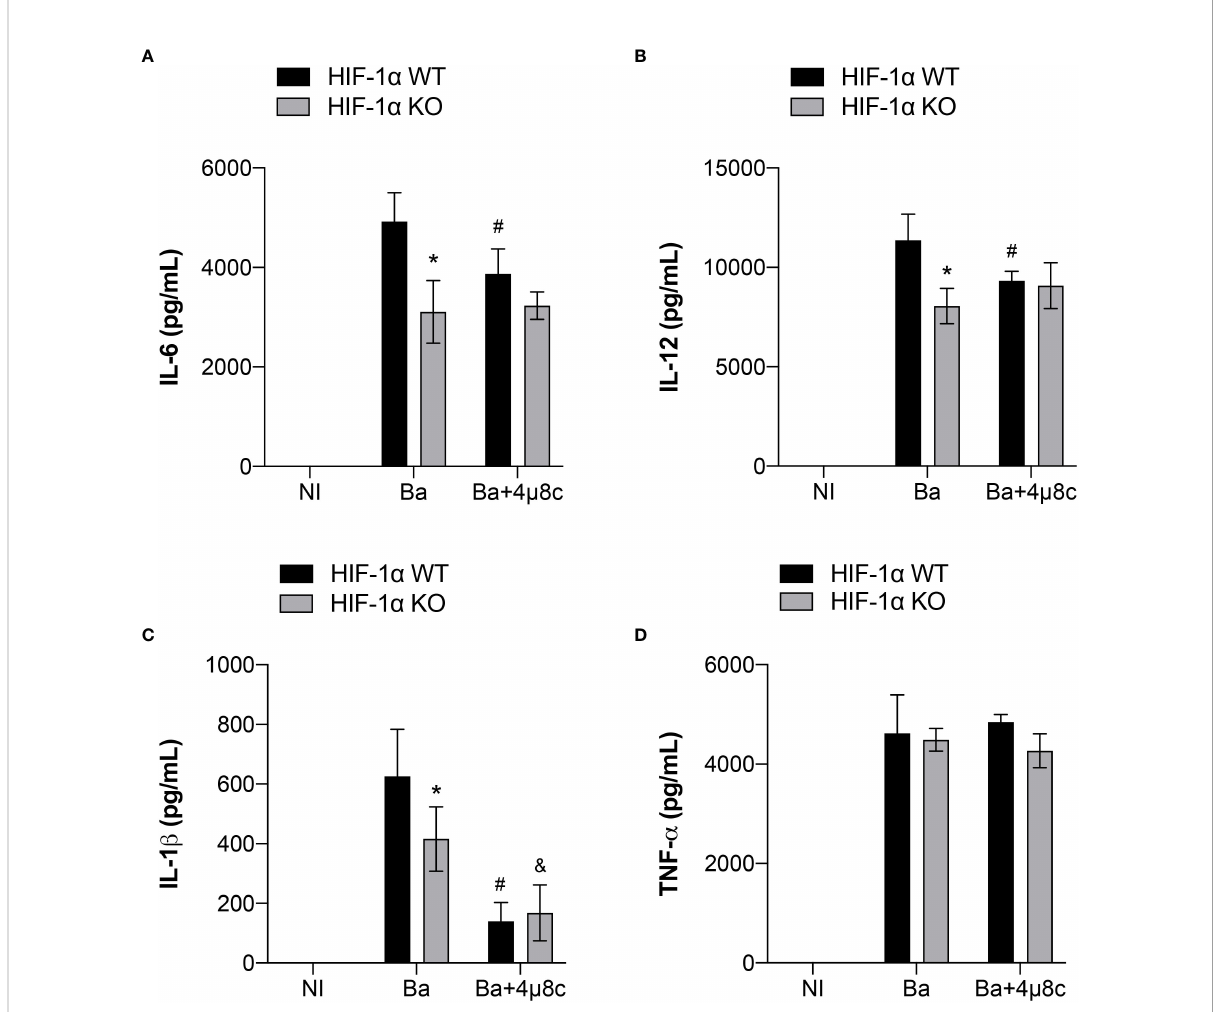
FIGURE 6 IRE1 a is necessary for full induction of HIF-1 a -dependent in fl ammatory responses during infection. (A) IL-6, (B) IL-12, (C) IL-1 b and (D) TNF- a produced by macrophages derived from HIF-1 a WT and HIF-1 a KO mice non-infected (NI), infected with B abortus (Ba) or pre-treated with 4 m 8c (50 m M) and infected with B abortus (Ba+4 m 8c), detected in cell supernatants using ELISA. The data are representative of three independent experiments. The data are presented as mean ± SD, * p < 0.05 (compared between WT and KO), # p < 0.05 (compared to Ba from WT), & p < 0.05 (compared to Ba from KO), two-way